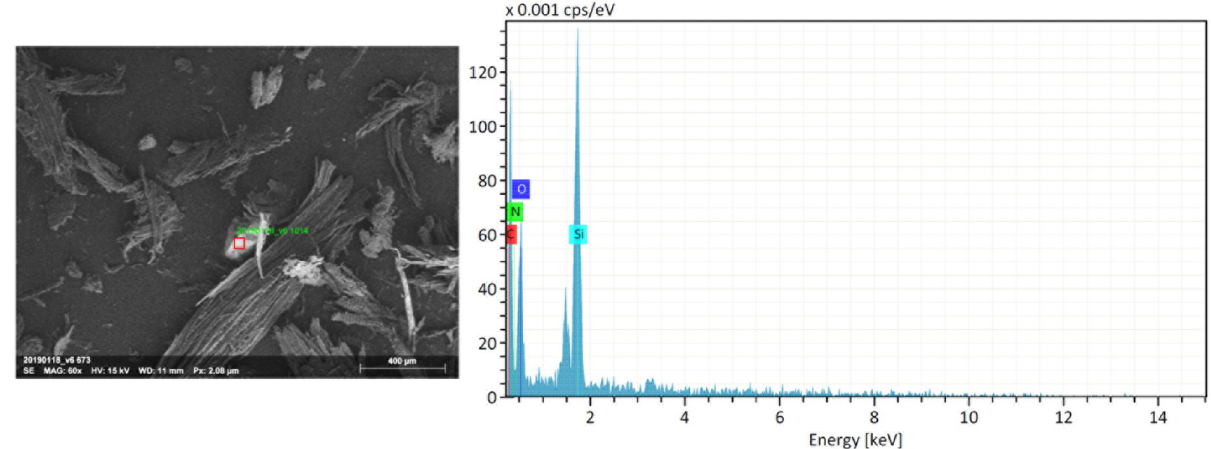
Fig 9. X-ray microanalysis of the spruce wood powder. The red square represents the scanned area. This area is mainly composed of Silicon, suggesting that the fragment (white on the picture) is a flint fragment.